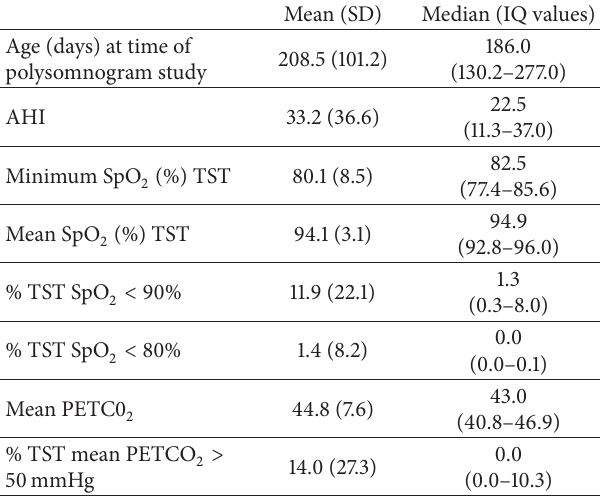
Table 1: Patient demographic and descriptive polysomnogram data.